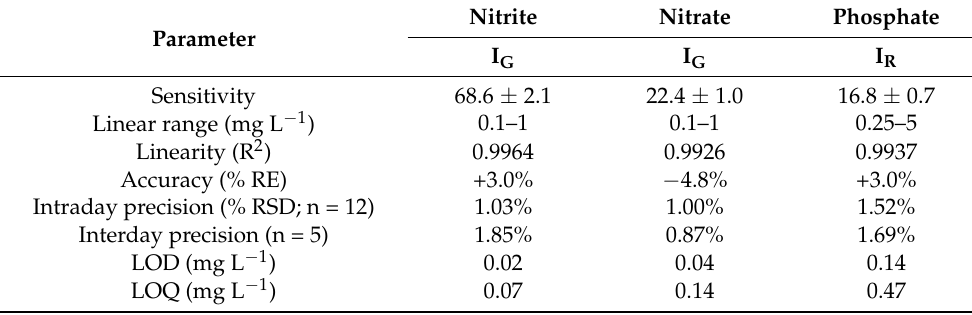
Table 1. Nutrient analysis performance of nutrient test kits and on-mobile DIC.